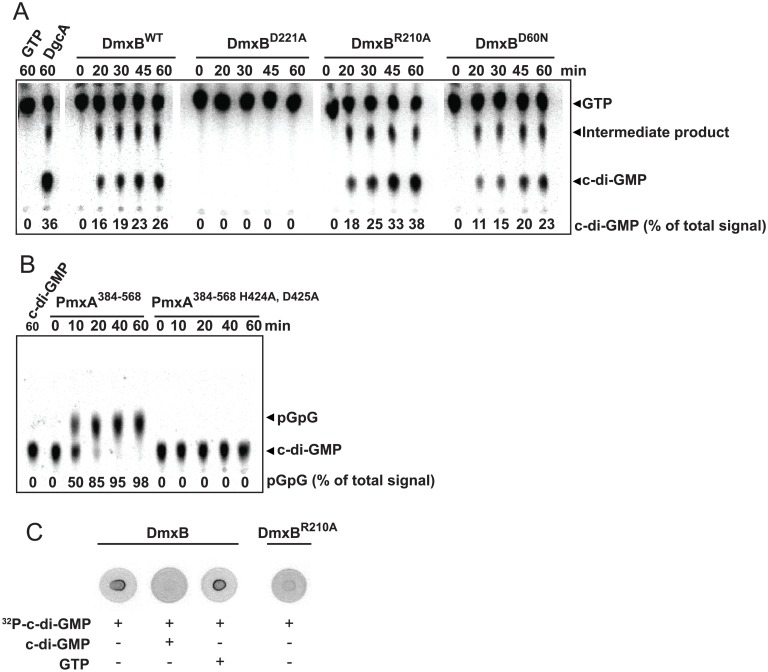
In vitro assay for enzyme activity and c-di-GMP binding.(A) DGC assay of DmxB variants. The indicated His6-tagged full-length DmxB variants were incubated with [α-32P]-GTP for the indicated periods of time followed by separation of nucleotides by TLC. Full-length DgcAWT was used as a positive control. GTP and c-di-GMP are indicated. The intermediate product indicated was described as a product formed during the DGC-dependent synthesis of c-di-GMP [49]. Numbers at the bottom indicate levels of c-di-GMP in % of the total signal in each lane. (B) PDE activity assay of PmxA. The indicated PmxA variants were incubated with [α-32P]-labeled c-di-GMP for the indicated periods of time followed by separation of nucleotides by TLC. pGpG and c-di-GMP are indicated. Numbers at the bottom indicate levels of pGpG in % of the total signal in each lane. (C) DRaCALA to detect c-di-GMP binding. The indicated full-length DmxB variants were incubated with [α-32P]-c-di-GMP with or without unlabeled c-di-GMP or GTP as competitors as indicated. 10 μl of the reaction mixtures were transferred to a nitrocellulose filter, dried and imaged.